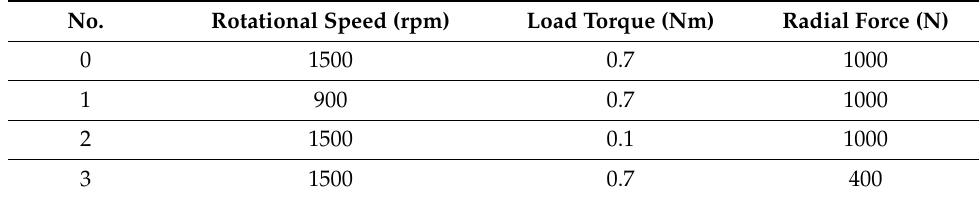
Table 1. Test rig operating